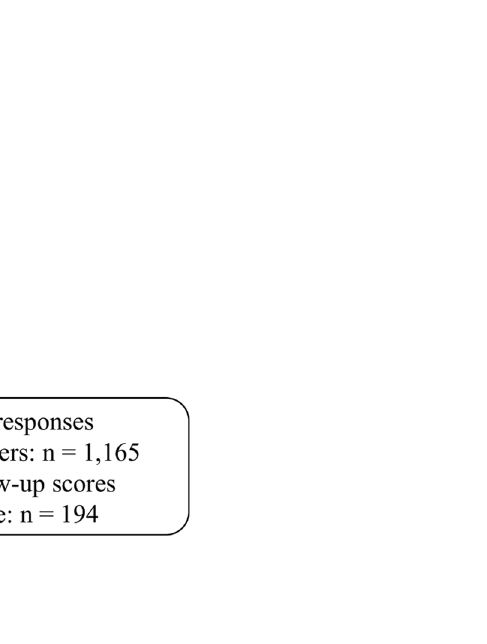
Fig 1. Flow diagram of the enrollment of study participants. ADL = activities of daily